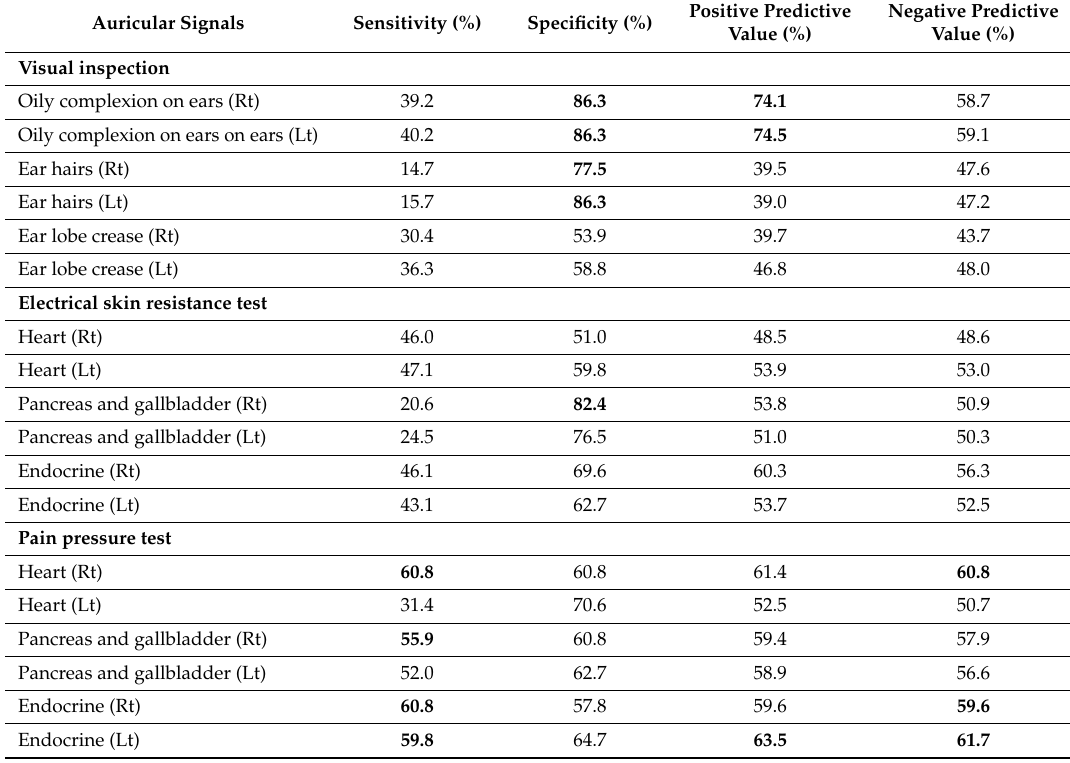
Table 5. Predictive power of auricular signals on the risk of metabolic syndrome ( n = 204). Auricular Signals Sensitivity (%) Specificity (%)